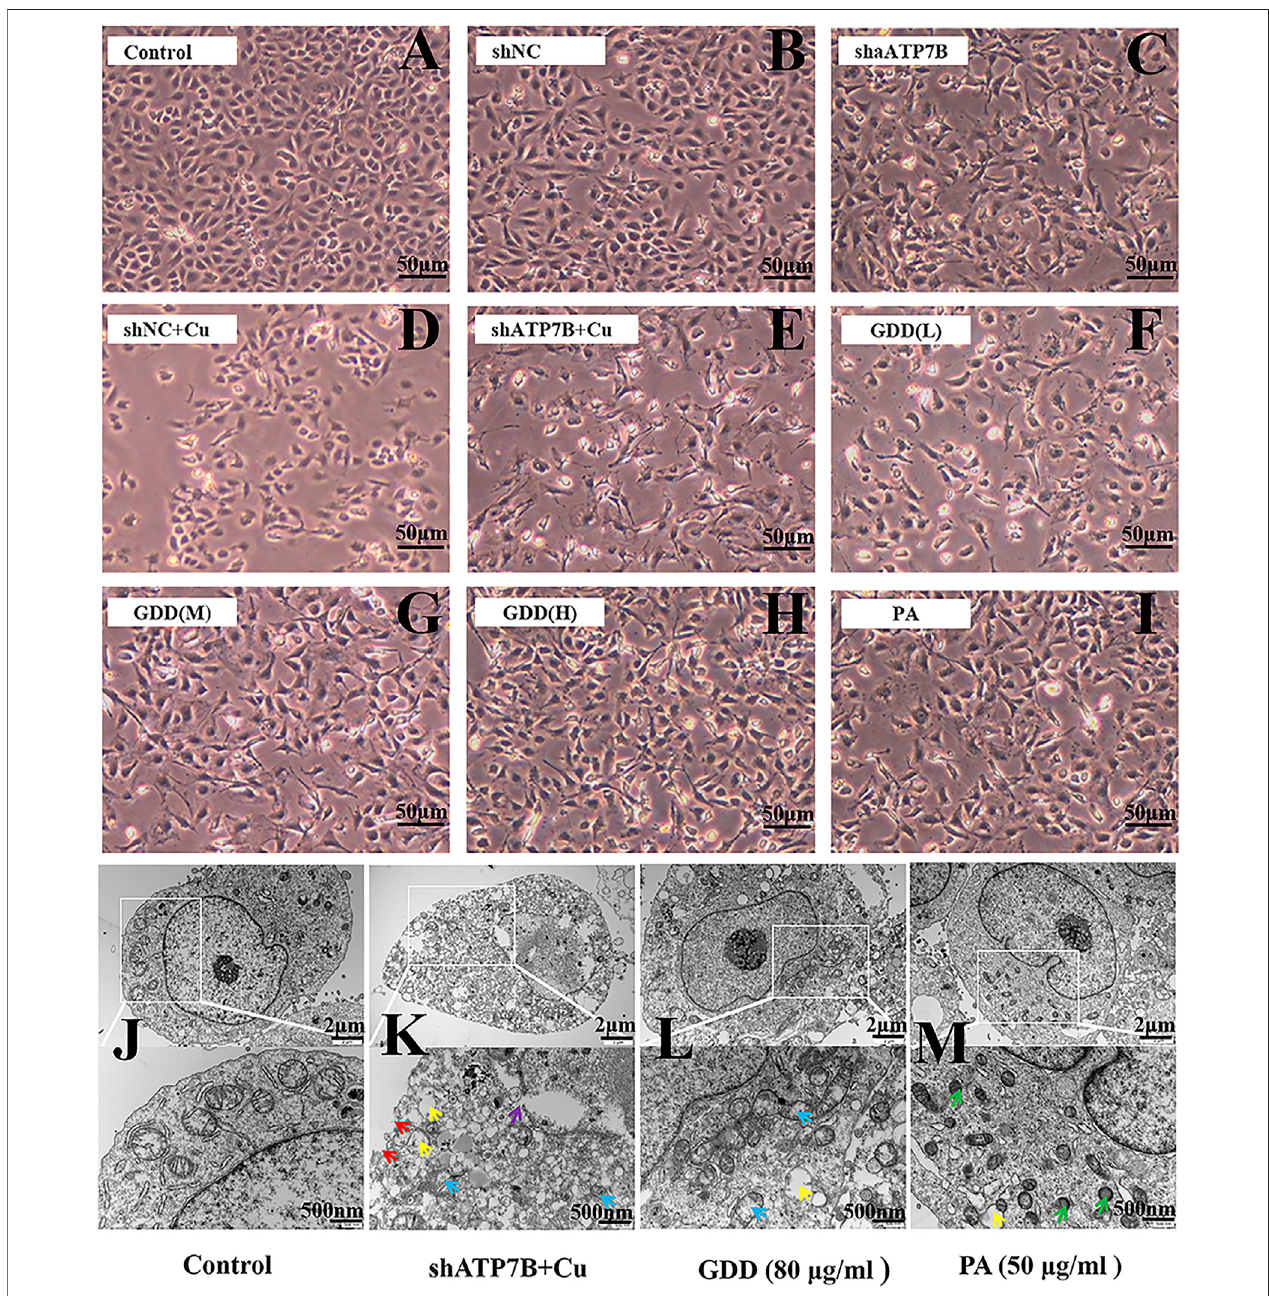
FIGURE3|(A – I) Morphologicalchangesofcopper-ladenHLDhepatocytestreatedwithGDDbyinvertedmicroscope(×200); (J – M) ultrastructureofcopper-laden HLD hepatocytes observed by transmission electron microscope (×10,000 or ×25,000) (red arrow: cell membrane rupture; yellow arrow: mitochondrial vacuolation; purple arrow: nuclear membrane rupture; blue arrow: mitochondrial cristal rupture; green arrow: mitochondrial shrinkage).